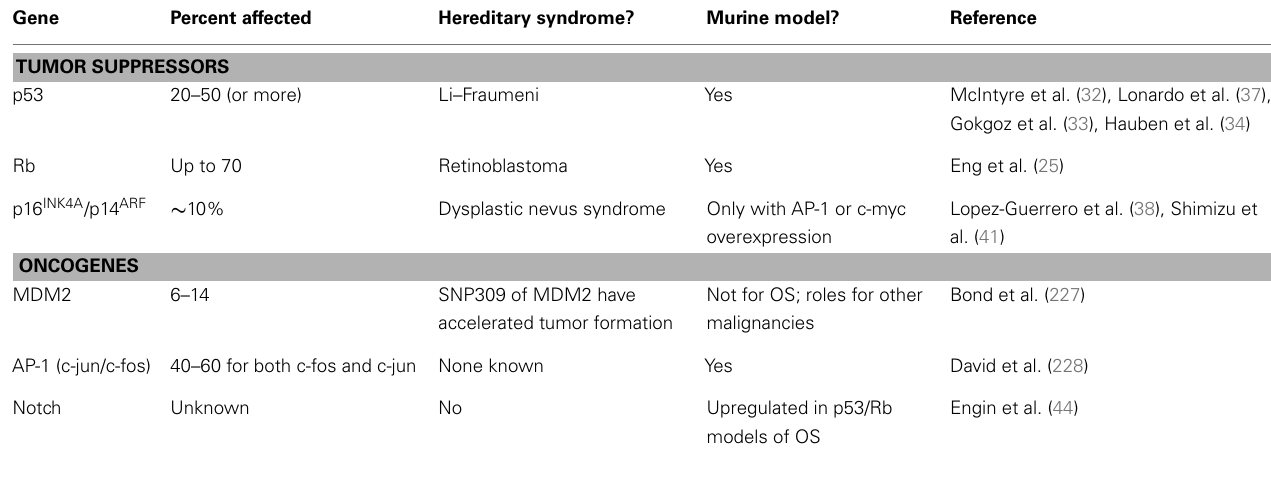
Table 1 | Genetic alterations in